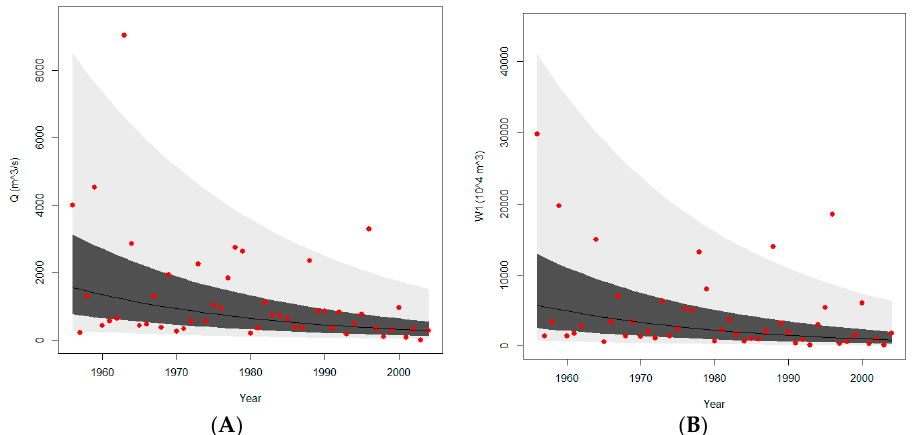
Figure 3. Summary of results of the univariate nonstationary model with Generalized Additive Models in Location, Scale, and Shape (GAMLSS) implementation. Red points represent the observed time series of peak discharge Q ( A ) and flood volume W 1 ( B ). The solid black line represents 0.5 quantile; the dark grey region is the area between 0.25 and 0.75 quantiles; the light grey region is the area between 0.05 and 0.95.